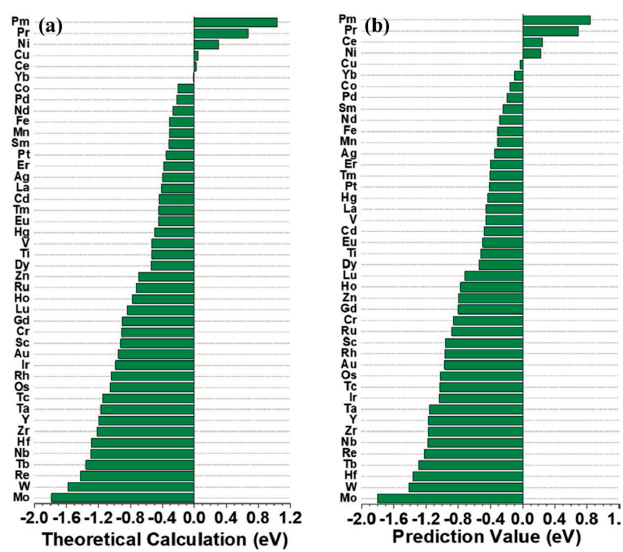
Figure 11. Prediction values of 2H adsorption energy calculated by ( a ) theoretical calculation and ( b ) machine learning (reproduced with permission from [119] . Copyright Wiley-VCH, 2020).